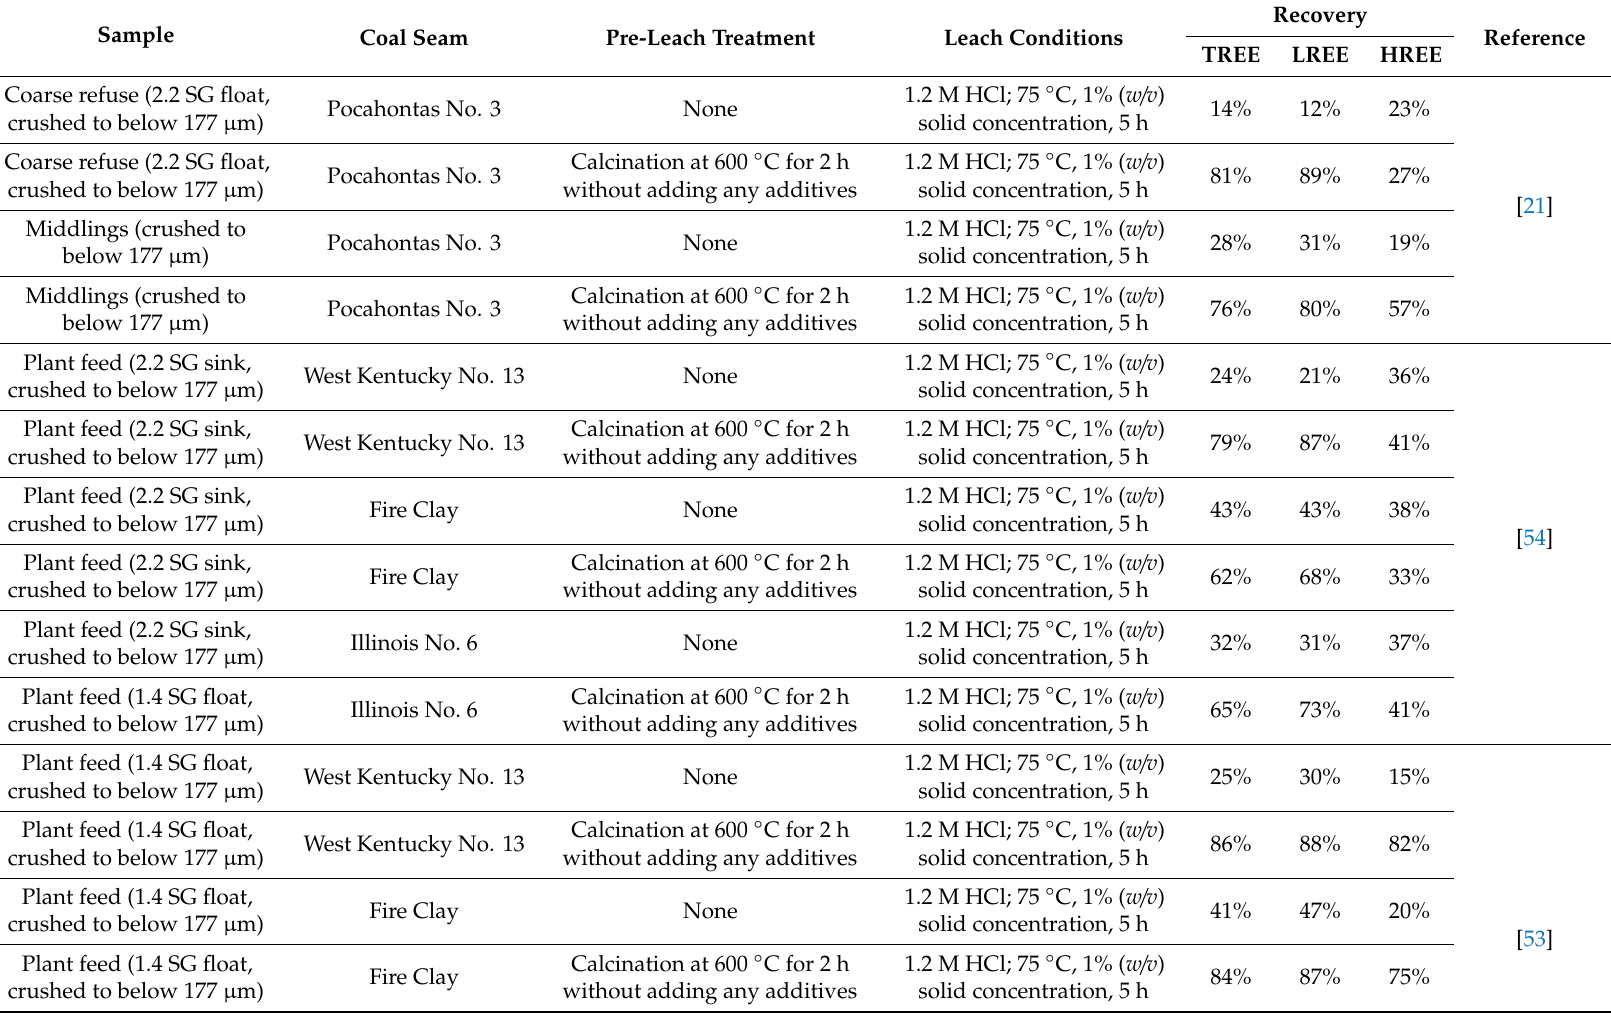
Table 3. Summary of the thermal and alkaline pretreatment e ff ects on the leaching recoveries of REEs from coal and coal